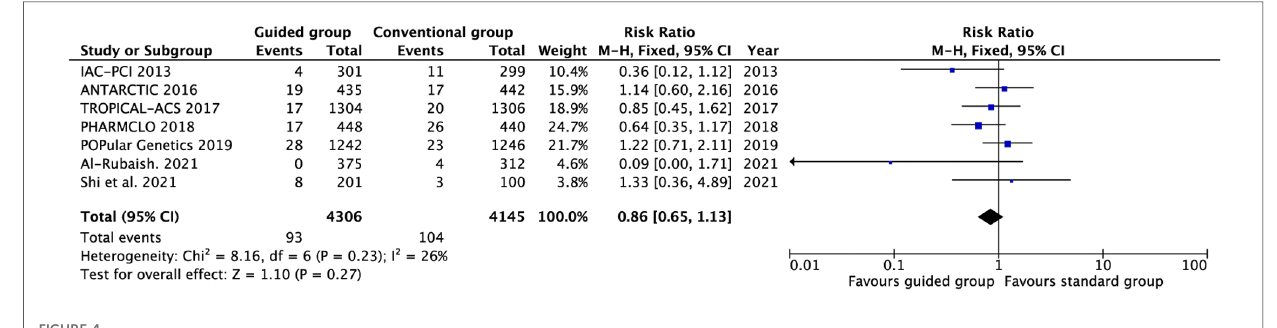
FIGURE 4 Pooled analyses of guided vs. conventional antiplatelet therapy for the safety